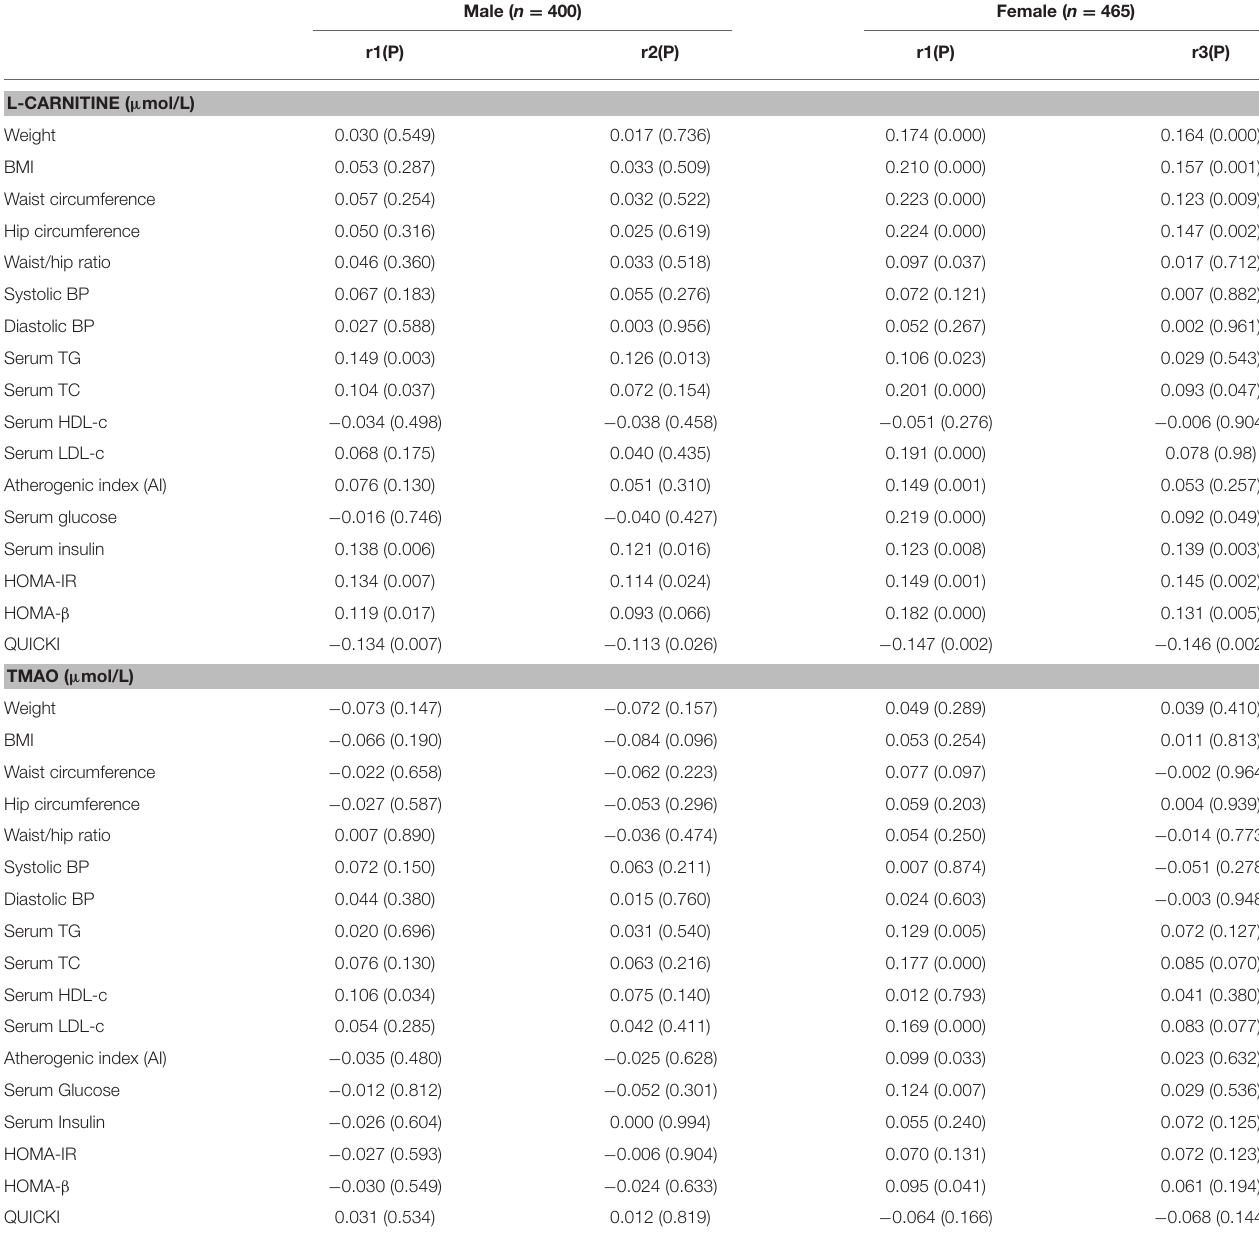
TABLE 4 | Partial correlations between serum L-Carnitine, TMAO levels with components of MS in females and males with normal serum glucose